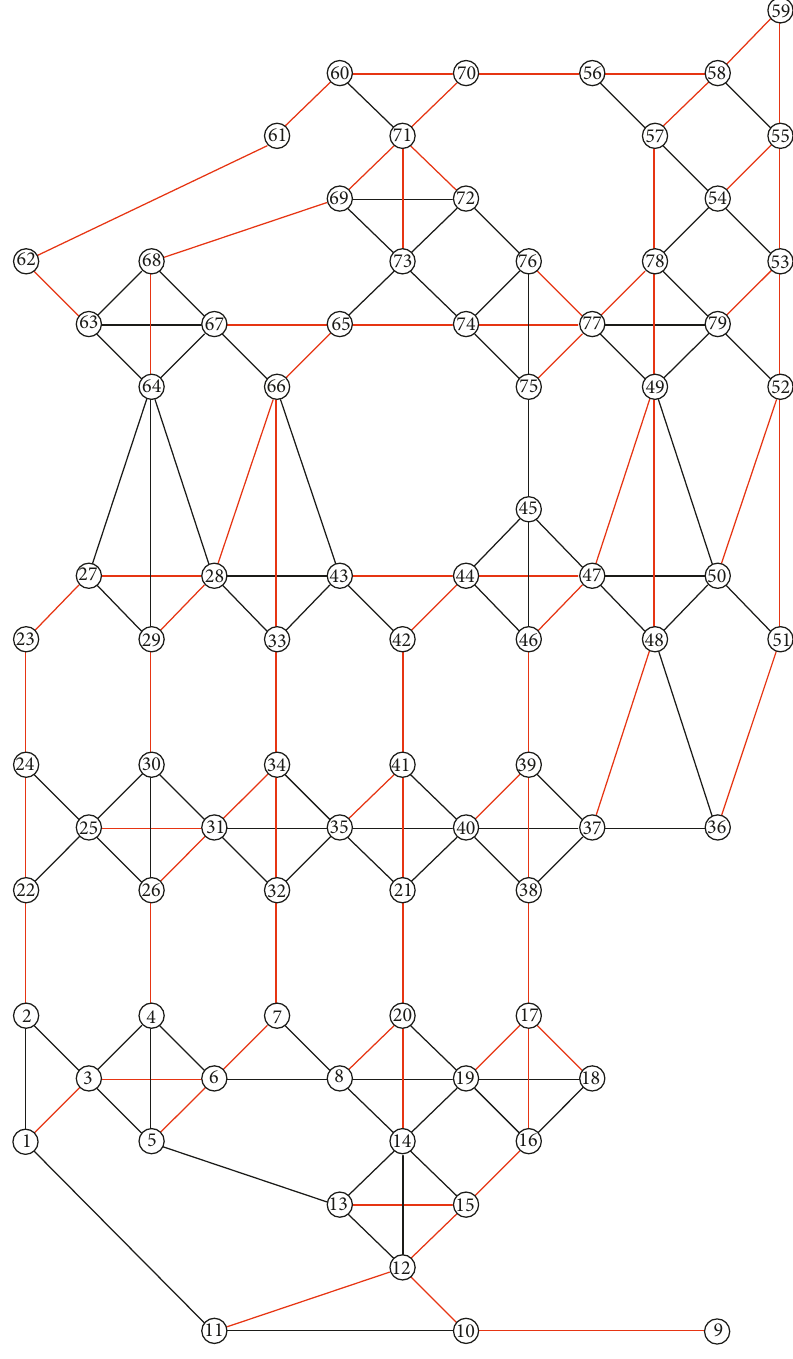
Figure 6: Shortest-path spanning tree of the line